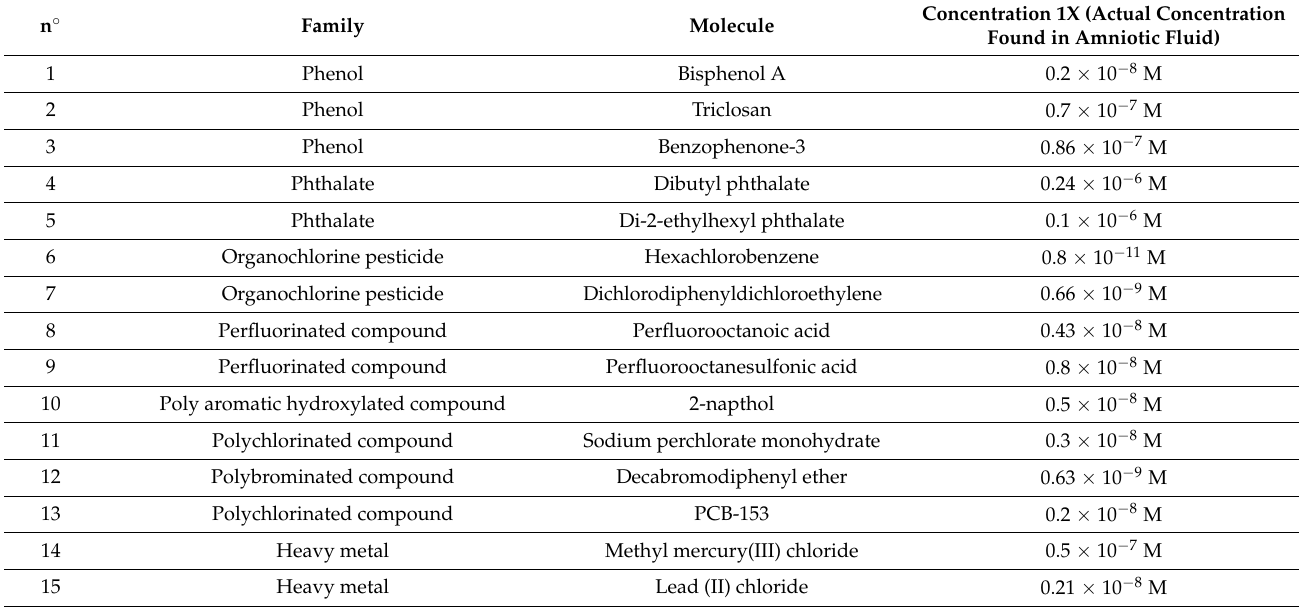
Table 1. Composition of chemical